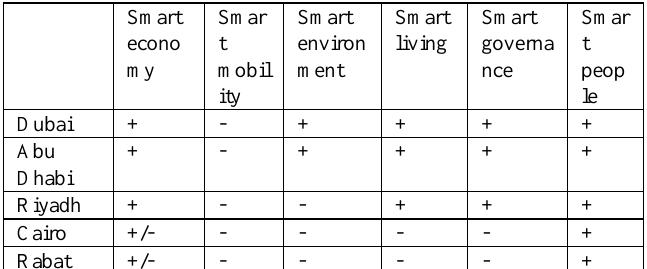
Table 2: dimensions of smart city (in five